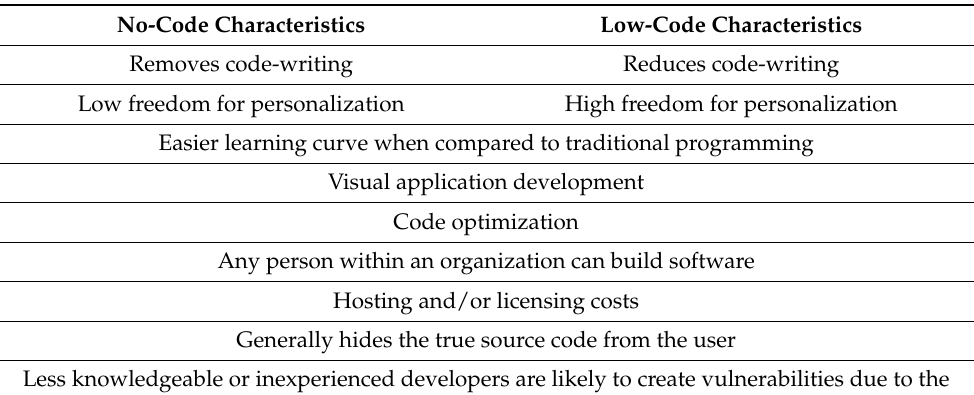
Table 1. No/low-code main